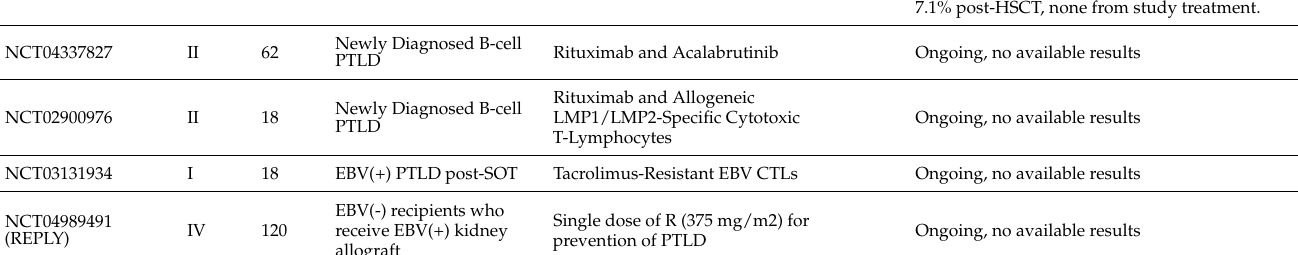
Table 3. Selected completed or ongoing clinical trials exclusively for PTLD patients.